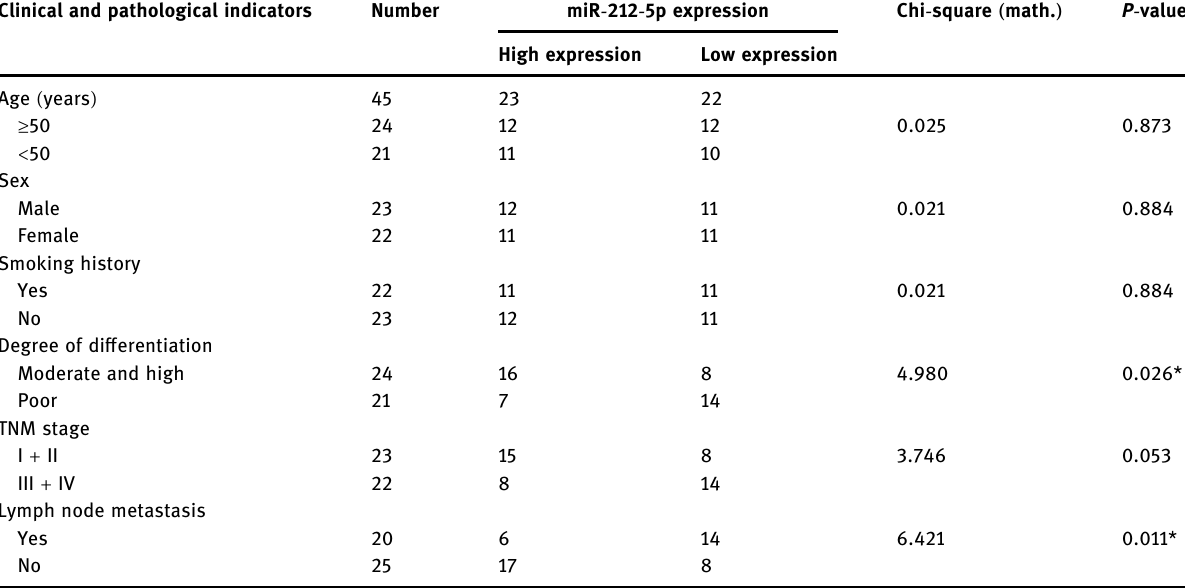
Table 1: The correlation between miR - 212 - 5p expression and clinicopathological characteristics of NPC patients Clinical and pathological indicators Number miR - 212 - 5p expression Chi - square ( math. ) P - value